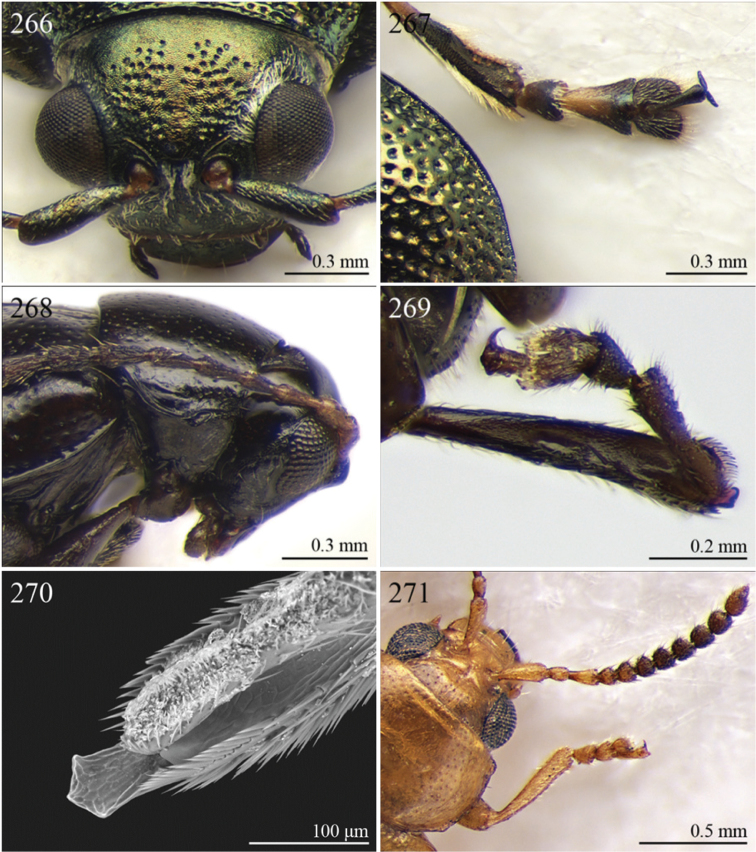
Morphological characters. 266
Terpnochlorus perrieri Fairmaire, head in subfrontal view 267 Ditto, metatarsus in dorsal view 268
Trachytetra guineensis (Bechyné), head and pronotum in lateral view 269 Ditto, hind tibia, metatarsus and apical spur 270
Tritonaphthona longicornis (Laboissière), trifid apical spur of hind tibiae 271
Upembaltica scolytina Bechyné, head and right antenna in dorsal view.